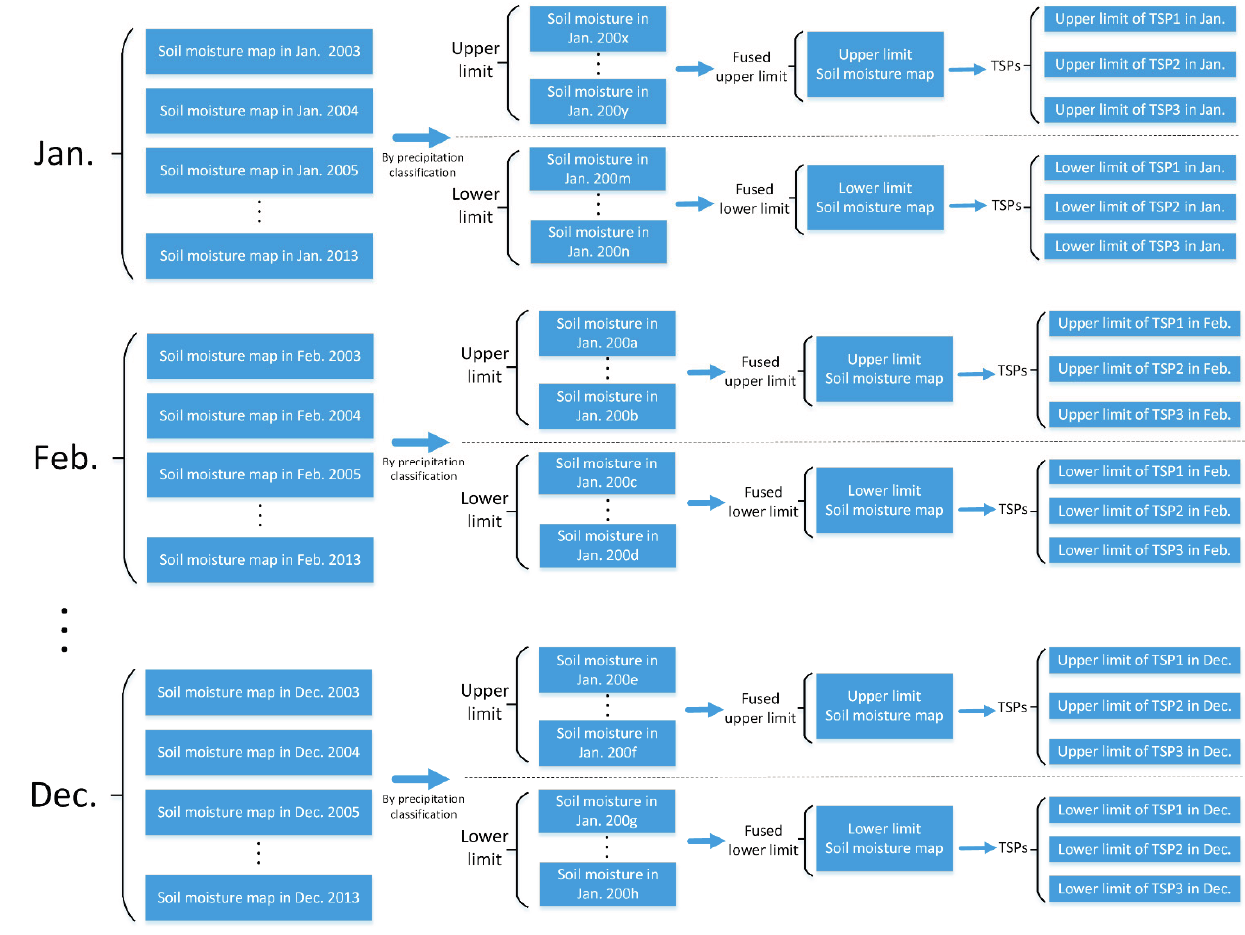
Figure 3. The flowchart showing how the STMC method extracts the spatial pattern and temporal variation laws based on long sequence remote sensing images and historical 200 e , 200 f , 200 g , and 200 h represents one year between 2003 and